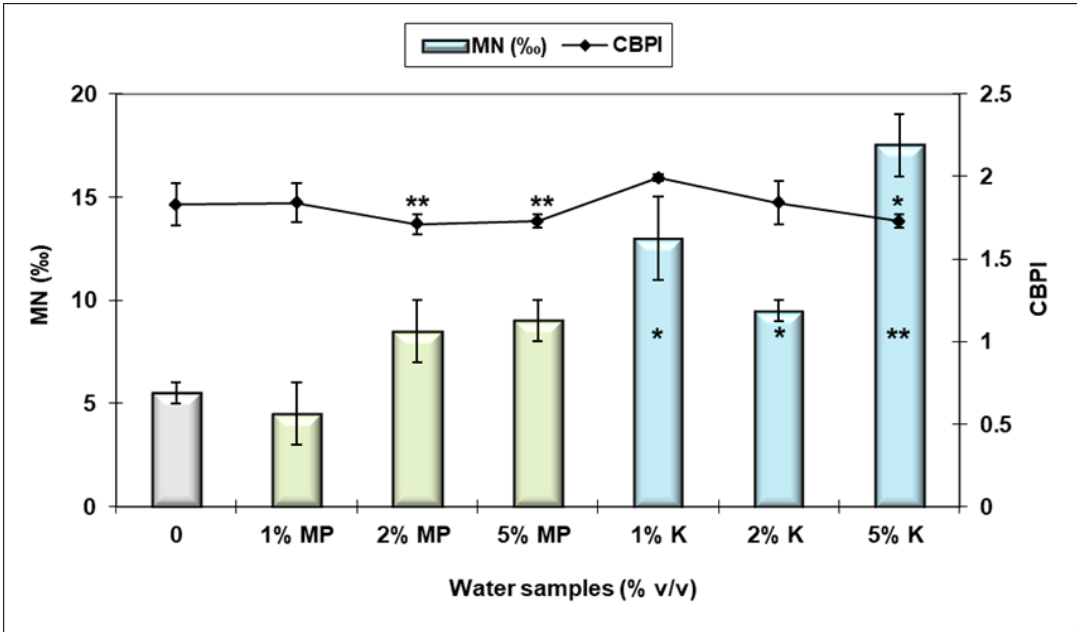
Figure 4. Frequencies of MN (histograms) and CBPI values (solid black line) in cultured human lymphocytes treated with different concentrations of surface water (1, 2, and 5%, v / v ) from Mikri Prespa (MP) and Kastoria (K) lakes (S1). MN, micronuclei; CBPI, cytokinesis-block proliferation index; mean MN frequencies, expressed as number of MN (‰) ± standard error per 2.000 binucleated cells per experimental point; mean CBPI values, expressed as number of CBPI ± standard error per 1.000 binucleated cells per experimental point [G-test for MN; χ 2 for CBPI]. The significant difference from control is indicated by the asterisks in each case (* p < 0.01; ** p < 0.001).